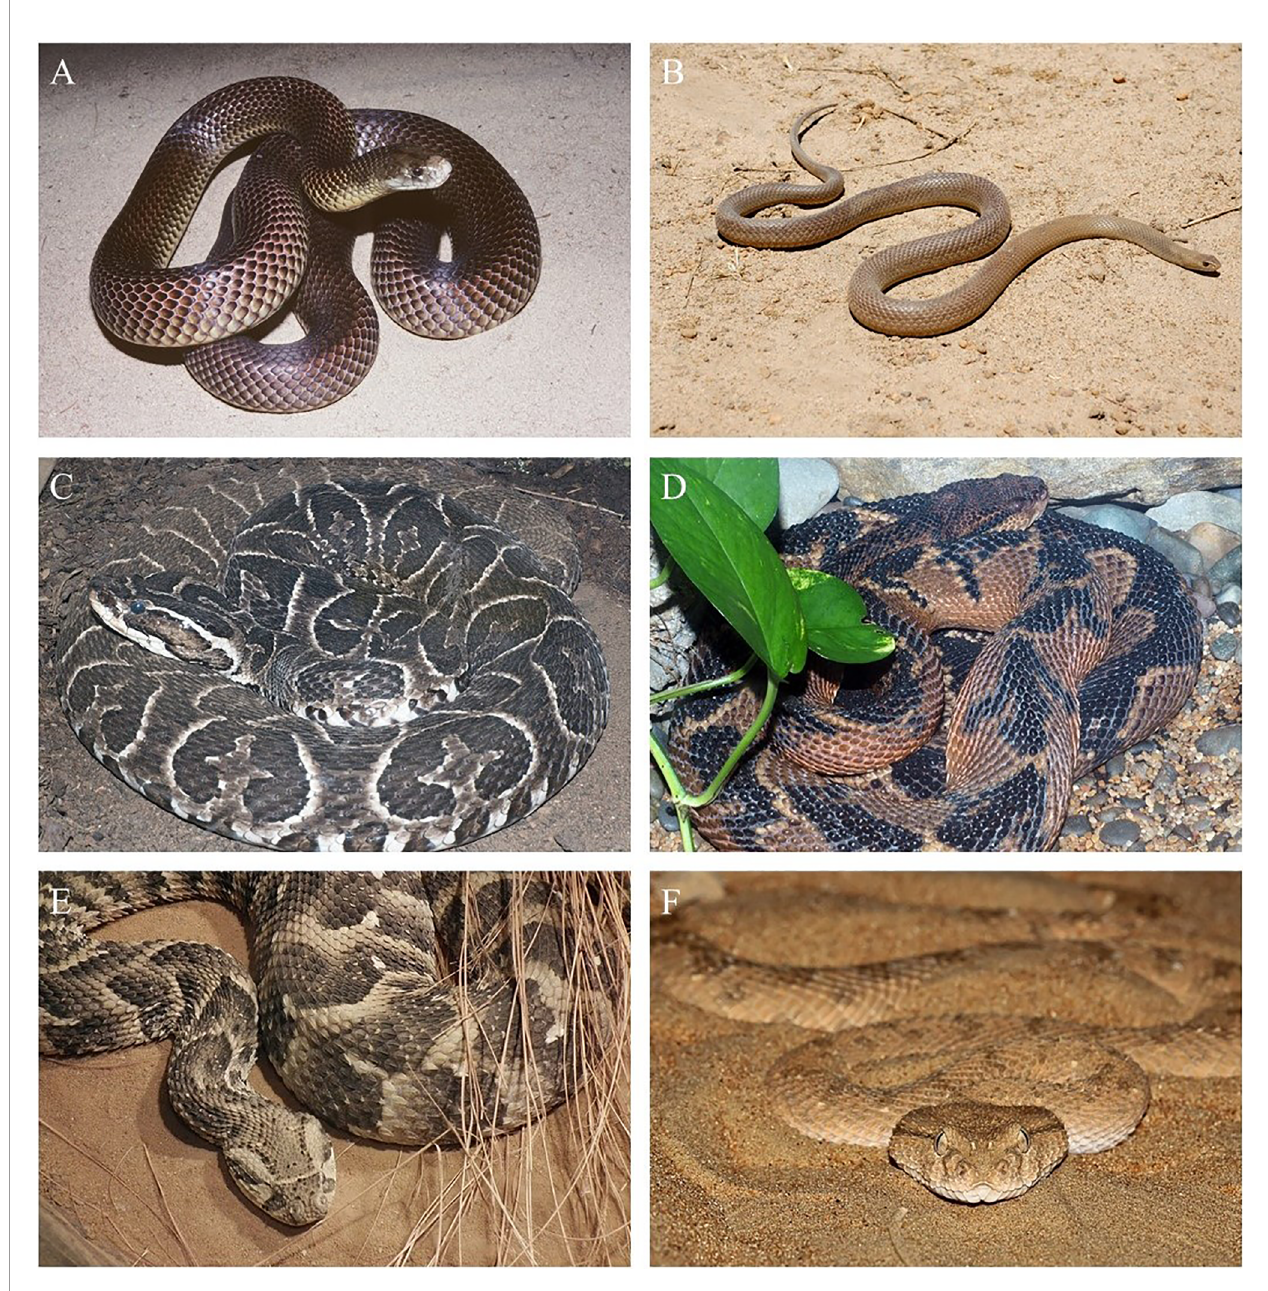
FIGURE 1 | Comparison of venomous snakes with similar names and/or appearance and/or clinical syndromes. Visual comparison of two Australian snakes with similar names and appearances: (A) A king brown snake ( Pseudonaja textilis ), which belongs to the black snake genus, and (B) an eastern brown snake ( Pseudonaja textilis ), which belongs to the brown snake genus. Visual comparison of two venomous snake species from Brazil: (C) Bothrops sp. and (D) Lachesis sp. Species from these genera can appear similar to those not trained in snake identi fi cation, can cause similar clinical manifestations, and are both locally known as ‘ surucucu ’ in certain parts of Brazil. Visual comparison of (E) a puff adder ( Bitis arietans ) and (F) a horned viper ( Cerastes cerastes ), the venoms of which can cause similar clinical manifestations. Figures 1A, C, D copyright © Prof. Julian White, Figure 1B copyright © of Prof. Sean Bush, 1E, 1F were found on WikiMedia Commons are are copyright © of the user 4028mdk09 and the user Broobas,